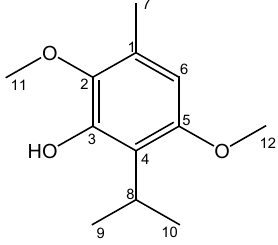
Figure 1. Structure of